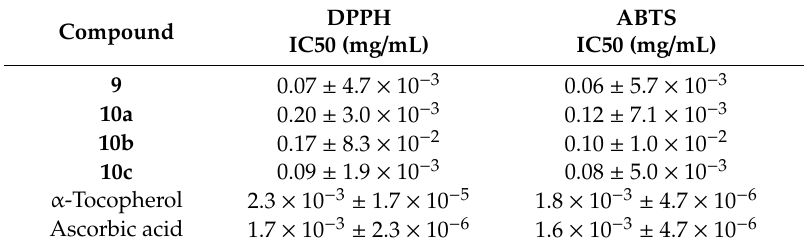
Table 2. DPPH and ABTS antioxidant activities of compounds 9 , 10a , 10b , and 10c , and positive controls (ascorbic acid and α -tocopherol). Values expressed are means ± S.D. of three parallel measurements.